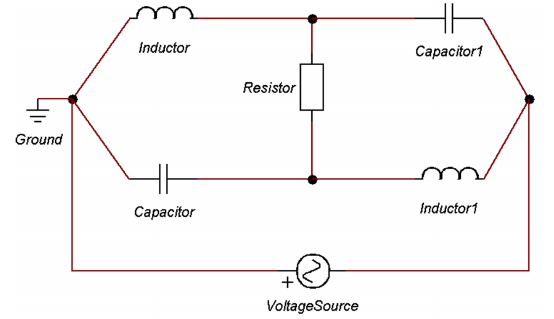
Figure 4: A forth order electrical circuit and each indicated as a 0-junction. Meaning